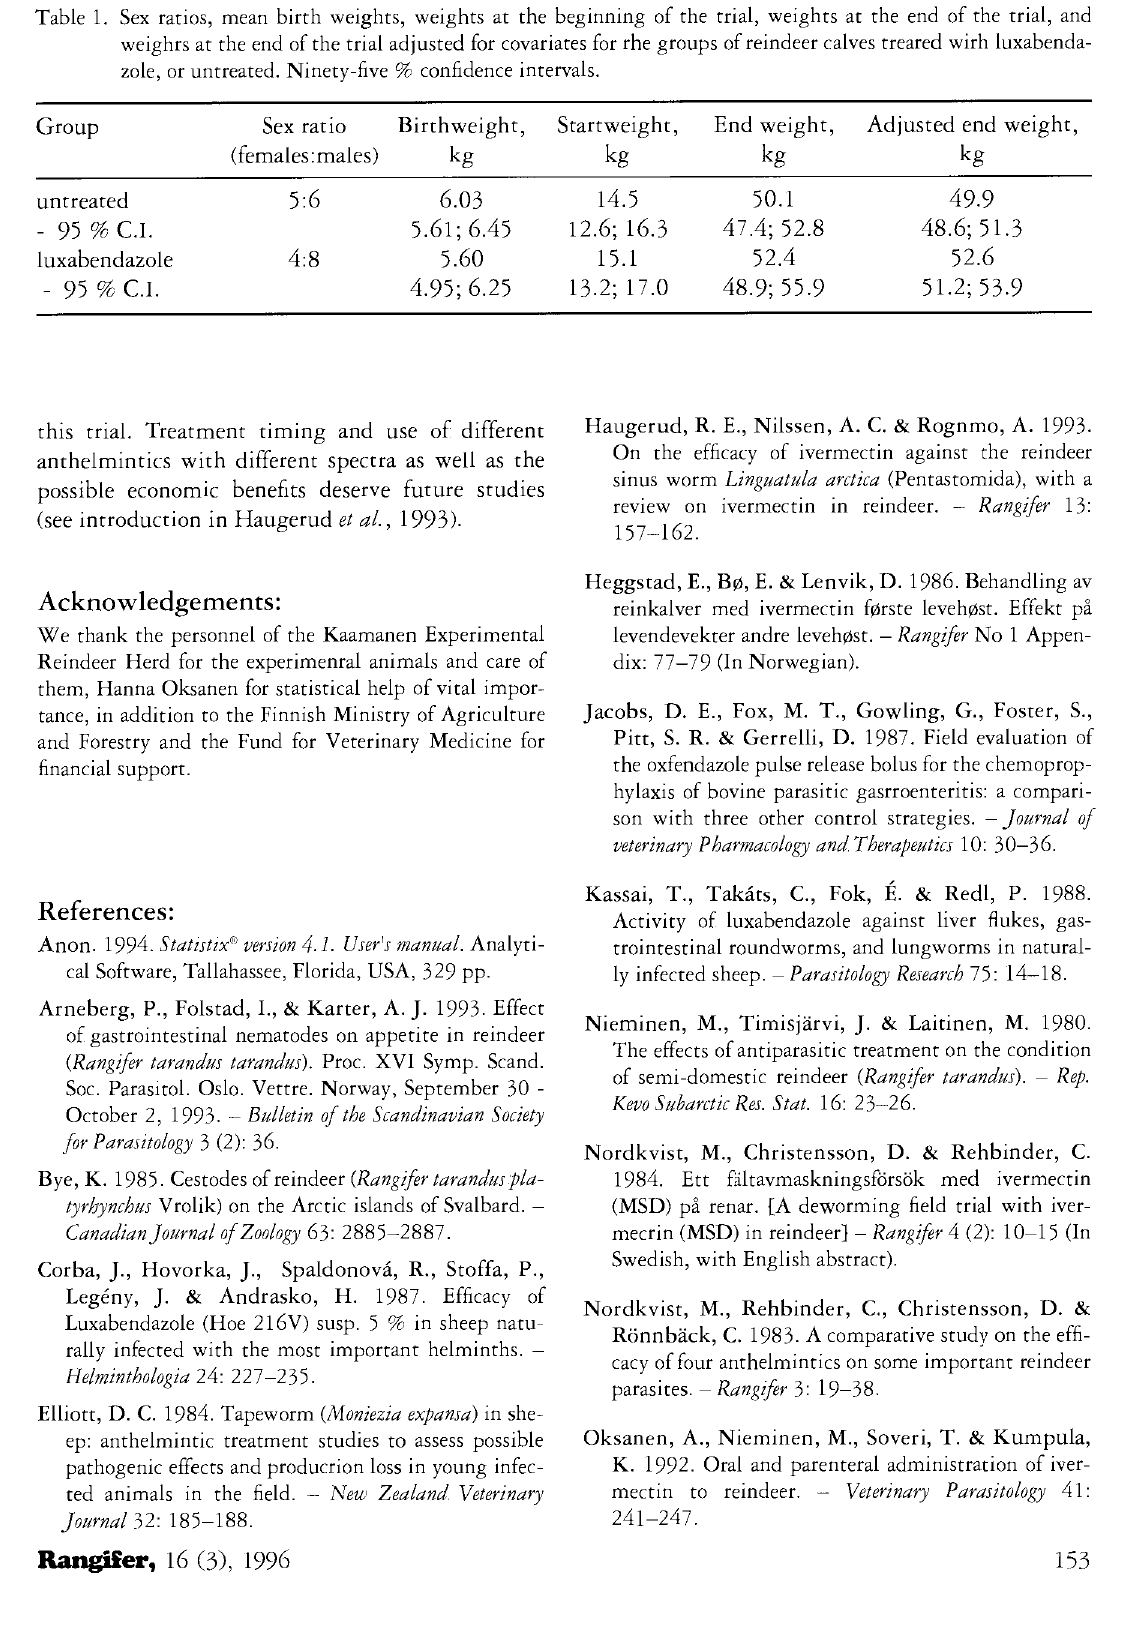
Table 1. Sex ratios, mean birth weights, weights at the beginning of the trial, weights at the end of the trial, and weighrs at the end of the trial adjusted for covariates for rhe groups of reindeer calves treared wirh luxabenda zole, or untreated. Ninety-five % confidence